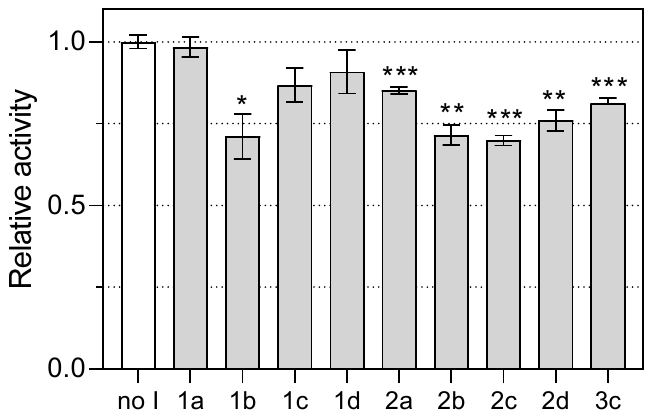
Figure 5. Effect of compounds 1a–d , 2a–d , and 3c on Pf DHODH activity. Asterisks denote statistically significant pairwise differences between the samples and uninhibited control (* p < 0.05, ** p < 0.01, *** p < 0.001) calculated with Welch’s t -test. The plot was drawn with GraphPad Prism 9.4 Software (GraphPad Inc., San Diego, CA, USA), which was also used for statistical comparison of data.